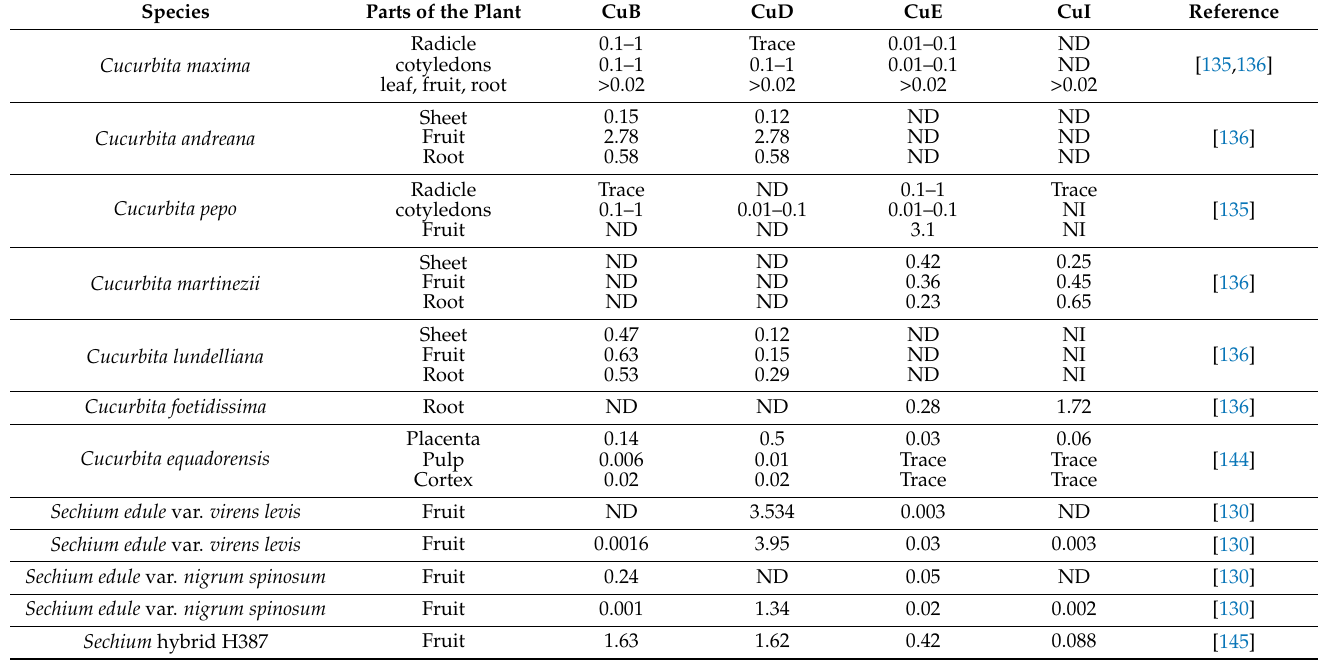
Table 4. Content of cucurbitacins B, D, E, and I (mg/g) in different neotropical plant species.